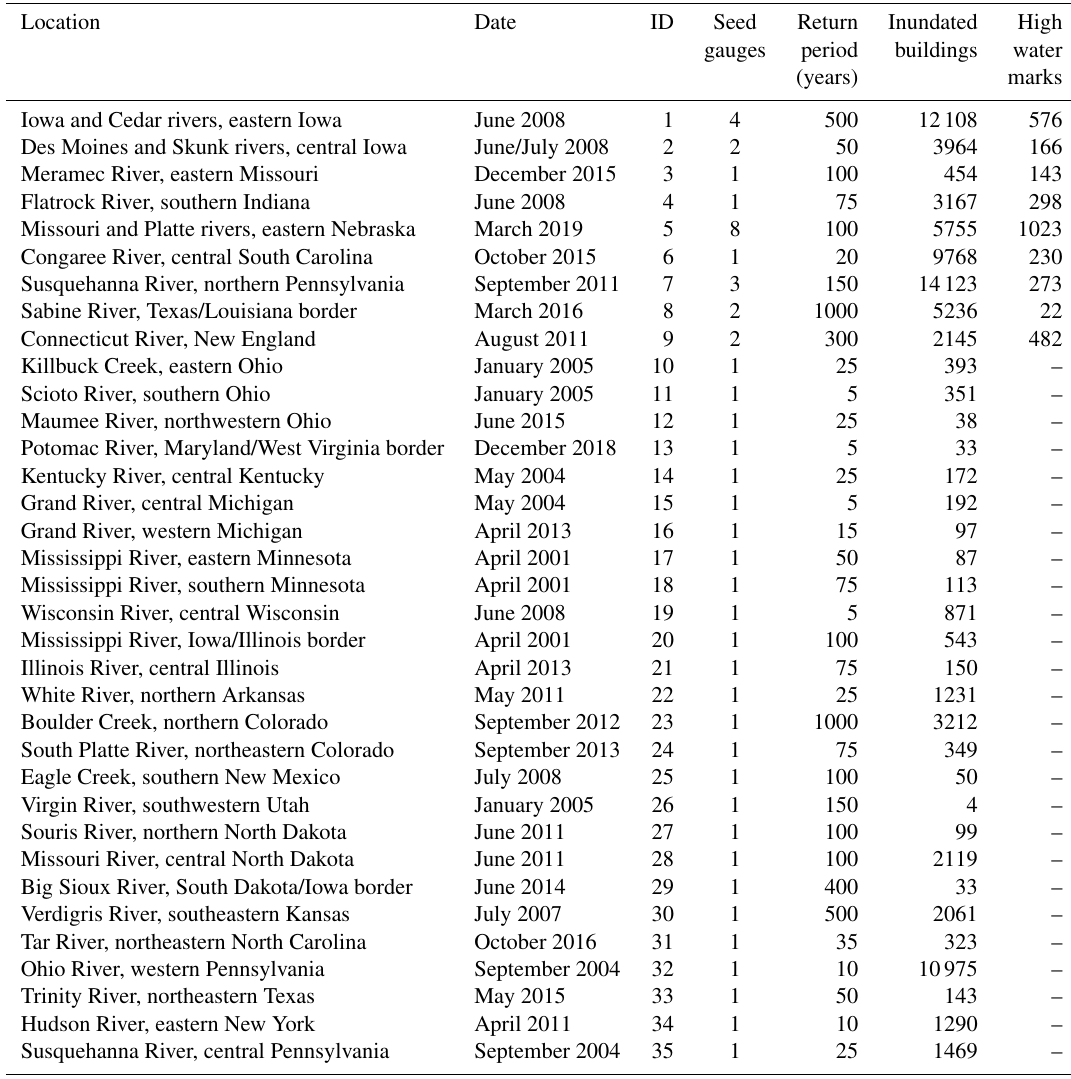
Table A1. The flood events simulated in this analysis. Return periods were obtained from USGS StreamStats data.